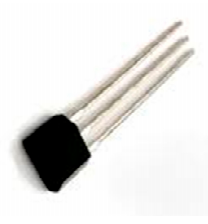
Figure 7. Smart glove with Hall sensors connected to the fingertip [25]. Some of the articles used the accelerometer ACC sensor to determine the shape and orientation of fingers [19–21,77,82,91]. If bending is the only target to be achieved, then only the flex sensor can deal with the problem. However, in sign language, hand movement and orientation are also considered to understand any sign perfectly. In the above-discussed sensors, orientation information cannot be captured. Therefore, an accelerometer sensor is used to determine the hand orientation for sign language recognition. The accelerometer works on Degree of Freedom (DoF) principles. This sensor has axis information along with different acceleration values provided by the sensor. This sensor is also embedded in a smart glove to perfectly distinguish signs made by the user. There are a lot of versions of accelerometer sensors that are used accordingly depending upon the situation to be faced. Normally for axis and orientation purposes, the ADXL335 version given below in Figure 8, made by Adafruit Industries in New York, is used. ADXL335 produces three-axis acceleration and three angles orientation. Physically, the device is very lightweight, small, thin in shape, and low power consuming. Depending upon the functionality and size of the sensor, its price ranges from $10 to $30. ADXL335 uses applications based on tilt- sensing to measure gravity acceleration statically. Dynamically, acceleration is